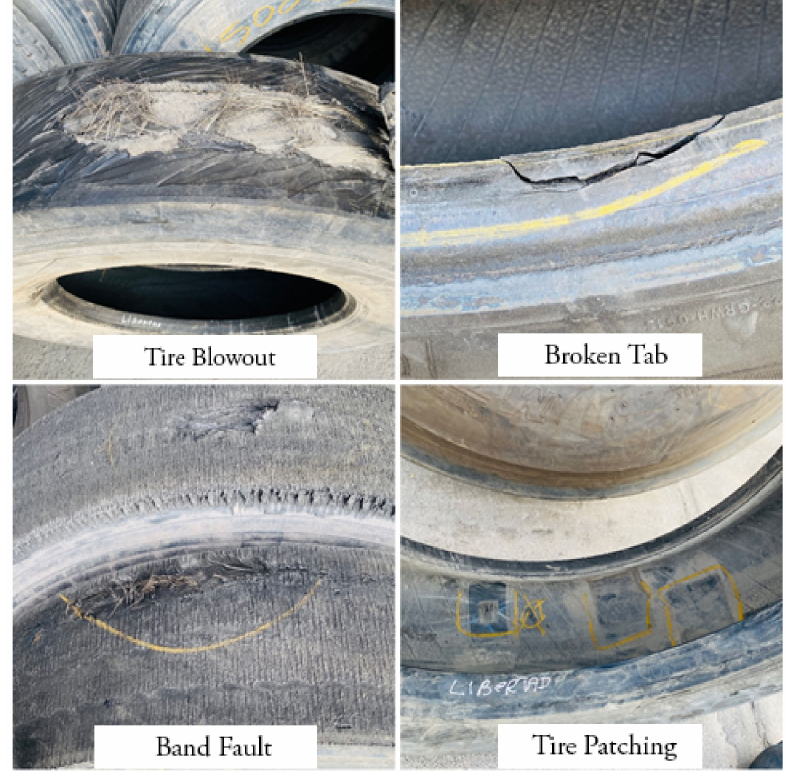
Figure 2. Tire Input